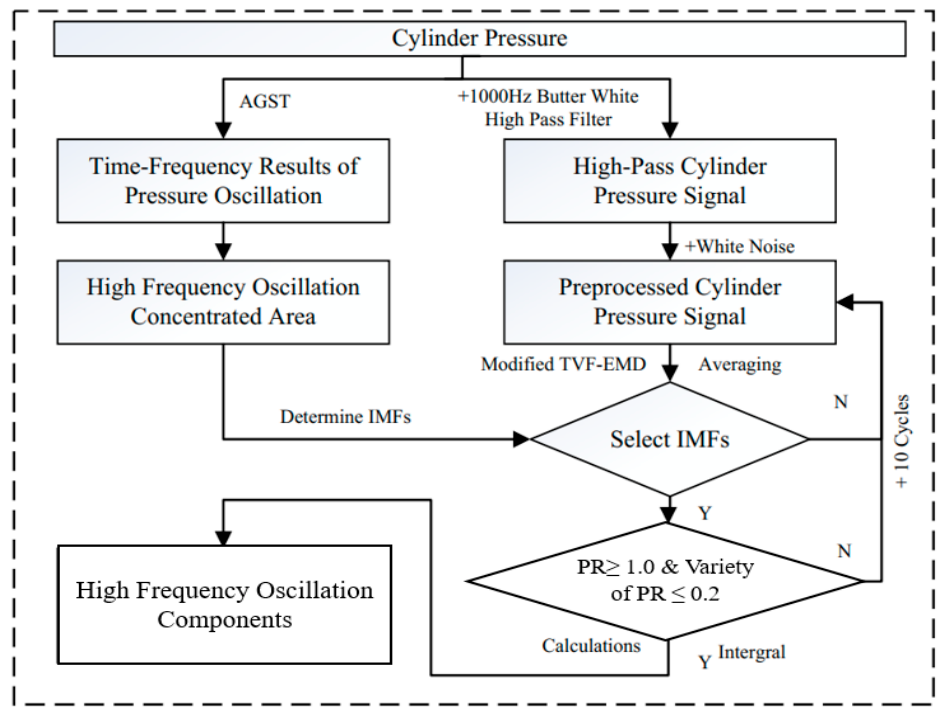
Figure 13. The method steps for identifying the in-cylinder high-frequency oscillation components.